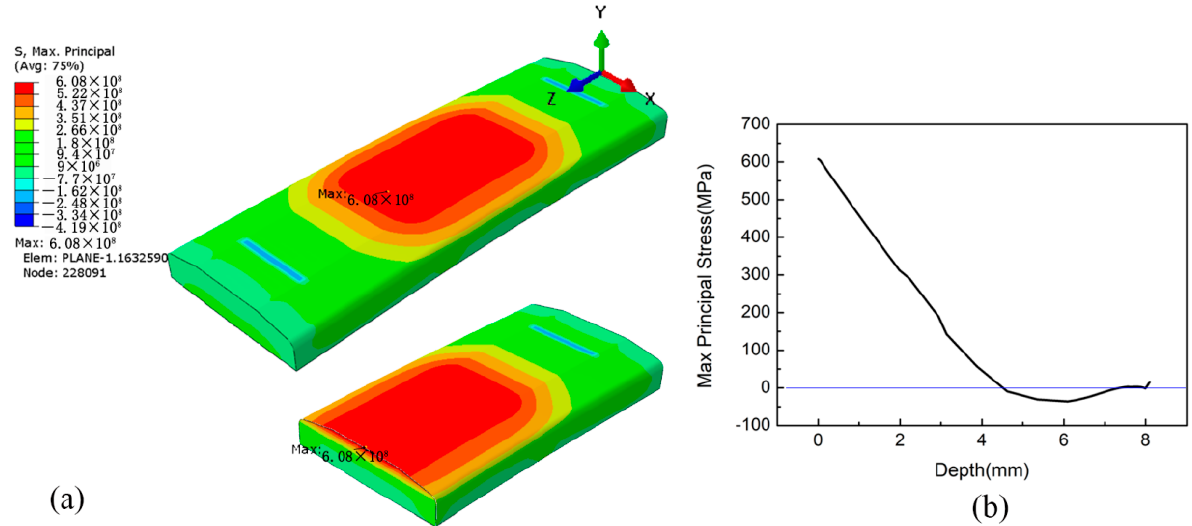
Figure 7. Maximum principal stress of the non-LSP specimen subjected to four-point bending: ( a ) stress field distribution; ( b ) stress curve along the depth passing through node No. 228091.